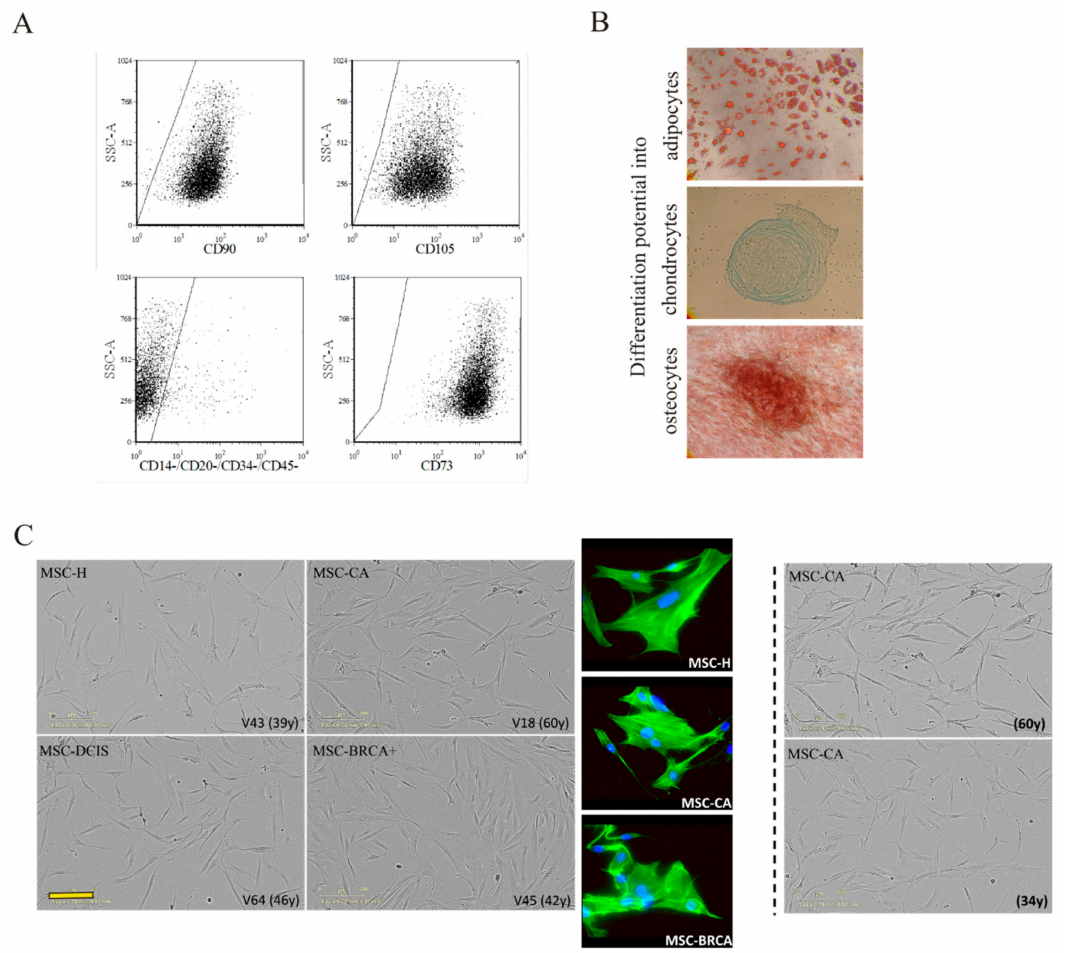
Figure 2. ( A ) MSC-specific marker expression was analyzed by flow cytometry. MSCs expressed CD73, CD90 and CD105 on their surface, but lacked hematopoietic / endothelial marker expression. ( B ) MSC multipotency was analyzed by their di ff erentiation potential into adipocytes, osteocytes, and chondrocytes. Magnification 100 × . ( C ) MSC phenotype was documented by